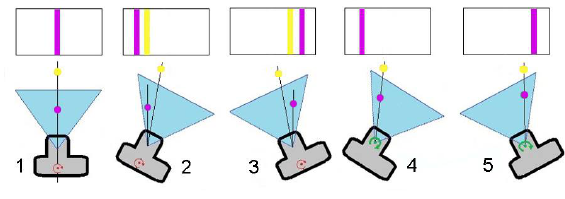
Figure 4. Finding the front nodal point.